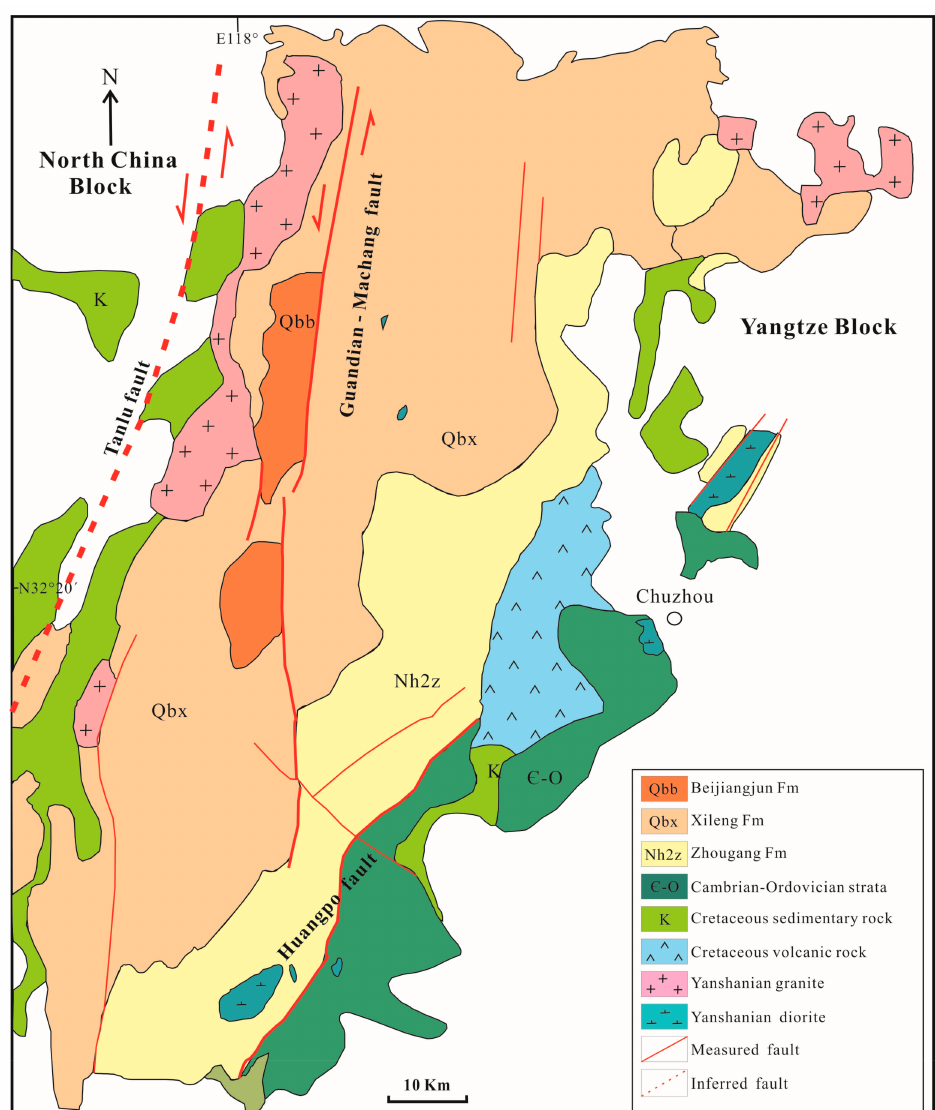
Figure 2. Simplified geological map of the northern Zhangbaling uplift after